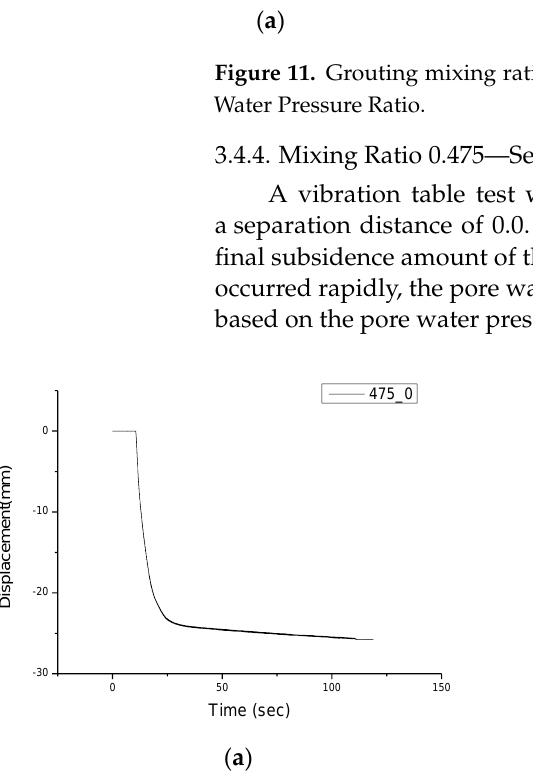
Figure 12. Grouting mixing ratio of 0.475 and separation distance of 0 cm: ( a ) Settlement ( b ) Pore Water Pressure Ratio.